Question: Condense the content of this figure into a single sentence.
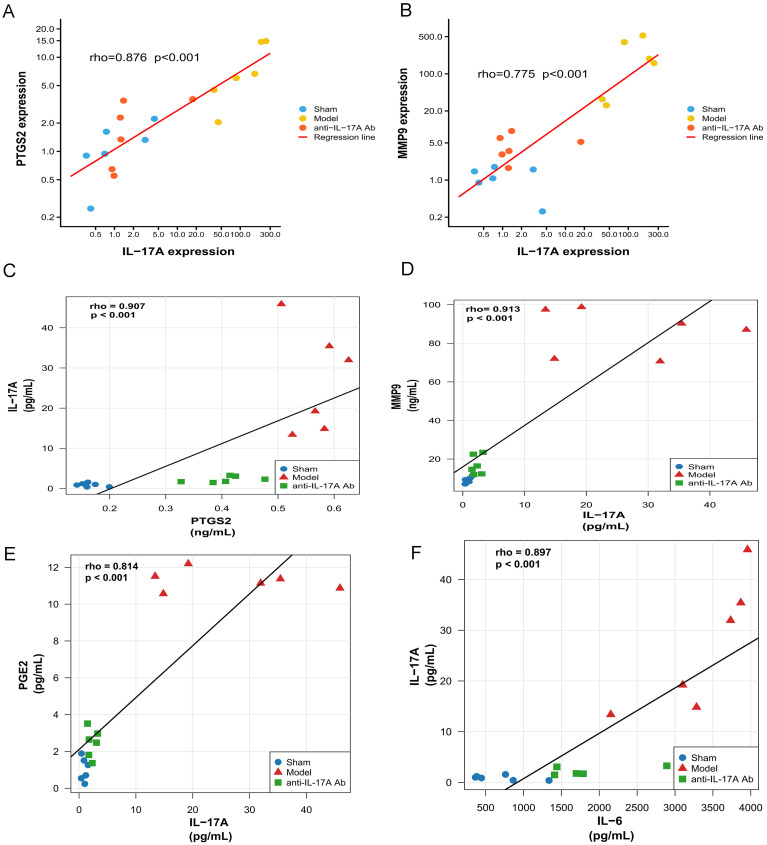
Answer: Spearman correlation analyses among IL-17A, PTGS2, MMP9, PGE2, and IL-6 in rat brain tissue. Correlation analyses were performed using pooled data from all animals (n = 18). (A) Correlation between IL-17A and PTGS2 mRNA expression. (B) Correlation between IL-17A and MMP9 mRNA expression. (C) Correlation between IL-17A and PTGS2 protein expression. (D) Correlation between IL-17A and MMP9 protein expression. (E) Correlation between IL-17A and PGE2 levels. (F) Correlation between IL-17A and IL-6 levels. Sham, sham-operated group; Model, MCAO group; anti-IL-17A Ab, IL-17A neutralizing antibody-treated MCAO group. Given the limited sample size, these correlations should be interpreted with caution.